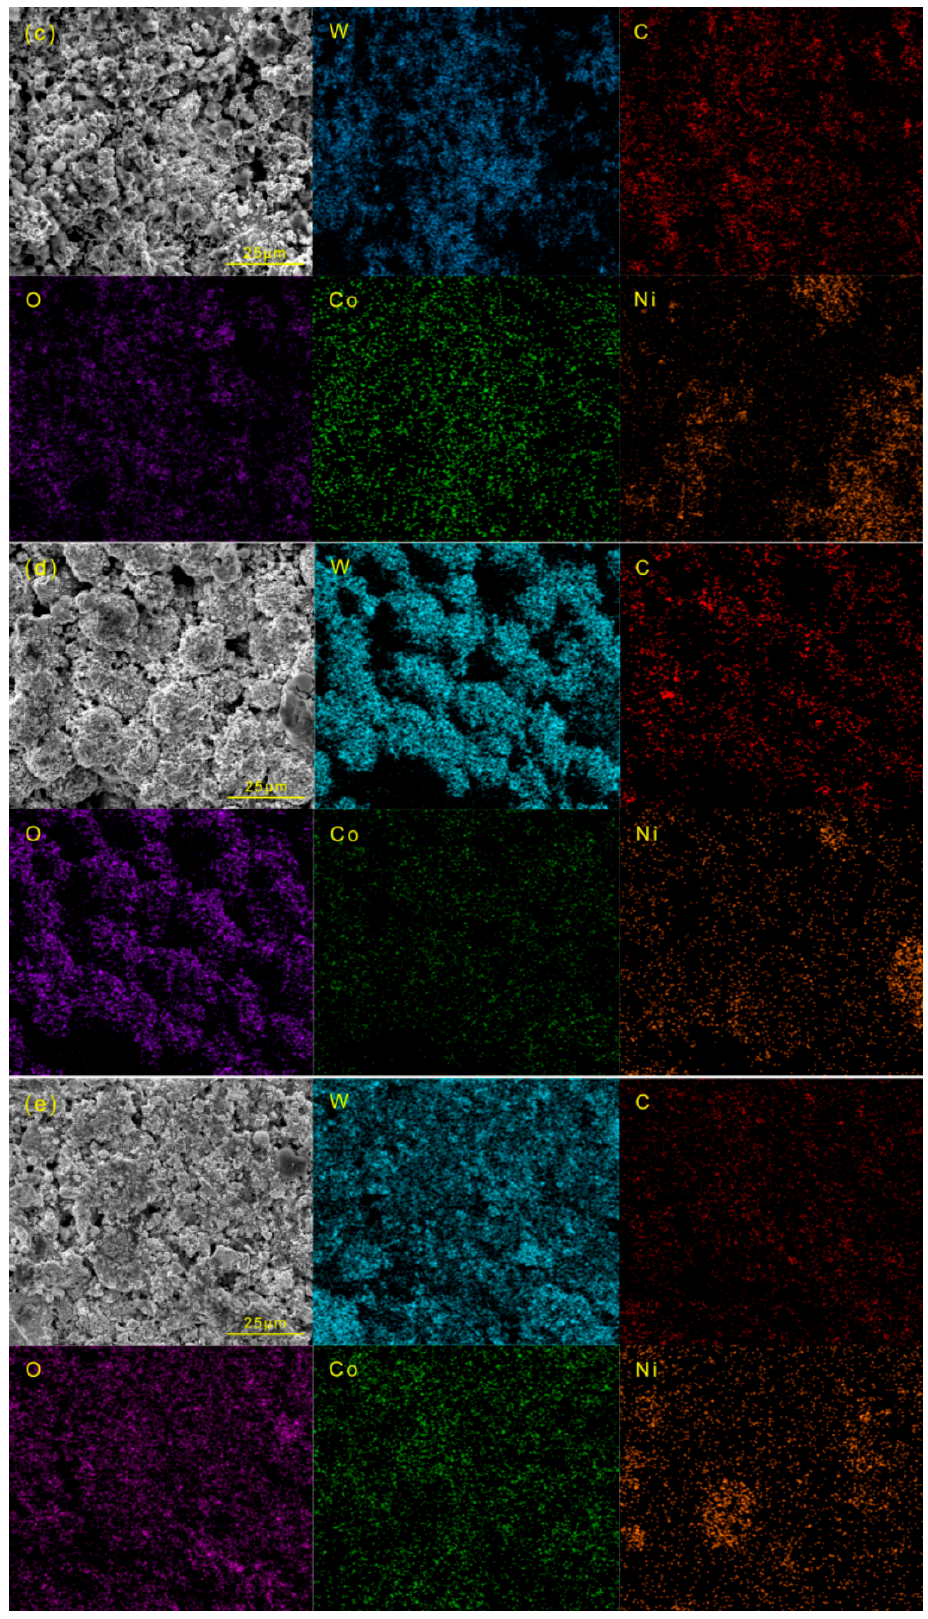
Figure 10. Morphologies after corrosion and element distribution: ( a ) H1; ( b ) E1; ( c ) H2; ( d ) E2; ( e ) E3.